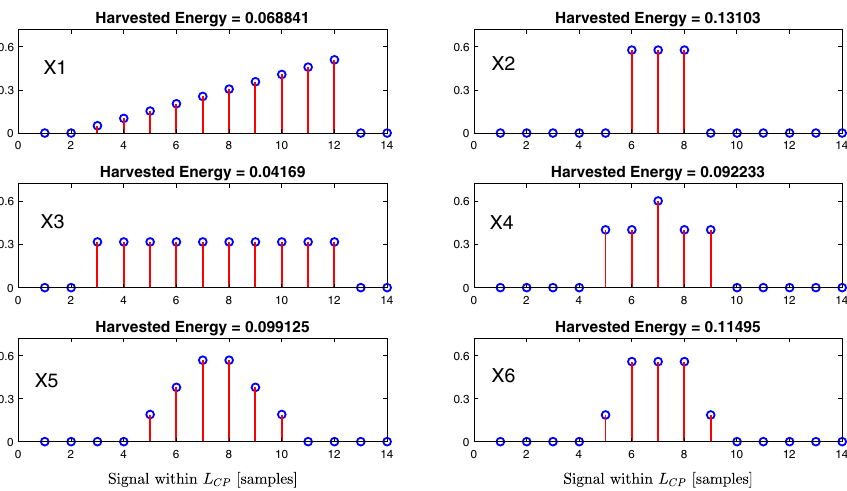
Fig. 6 Comparing different shapes of signals in terms of harvested energy using the nonlinear model of the